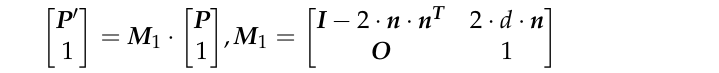
Figure 1. Calibration principle for reference plane. The camera C observes a point P on the reference plane via the plane mirror Π . We denote by i the incident ray and by l the reflected ray, R s 2 c and T s 2 c denote the pose parameters between the reference plane and the camera, n denotes the normal of the mirror, and d is the distance between C and Π . Based on the reflection property of the mirror, the relationship between this point and its mirror point is given by: